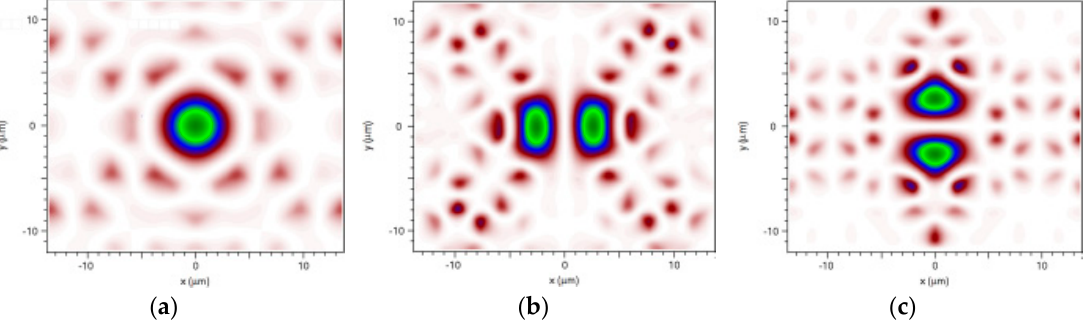
Figure 3. Field distributions of guided optical modes 4–6 in the HC-PBF without slow-light effect are shown in Figures ( a ), ( b ), and ( c ), respectively.